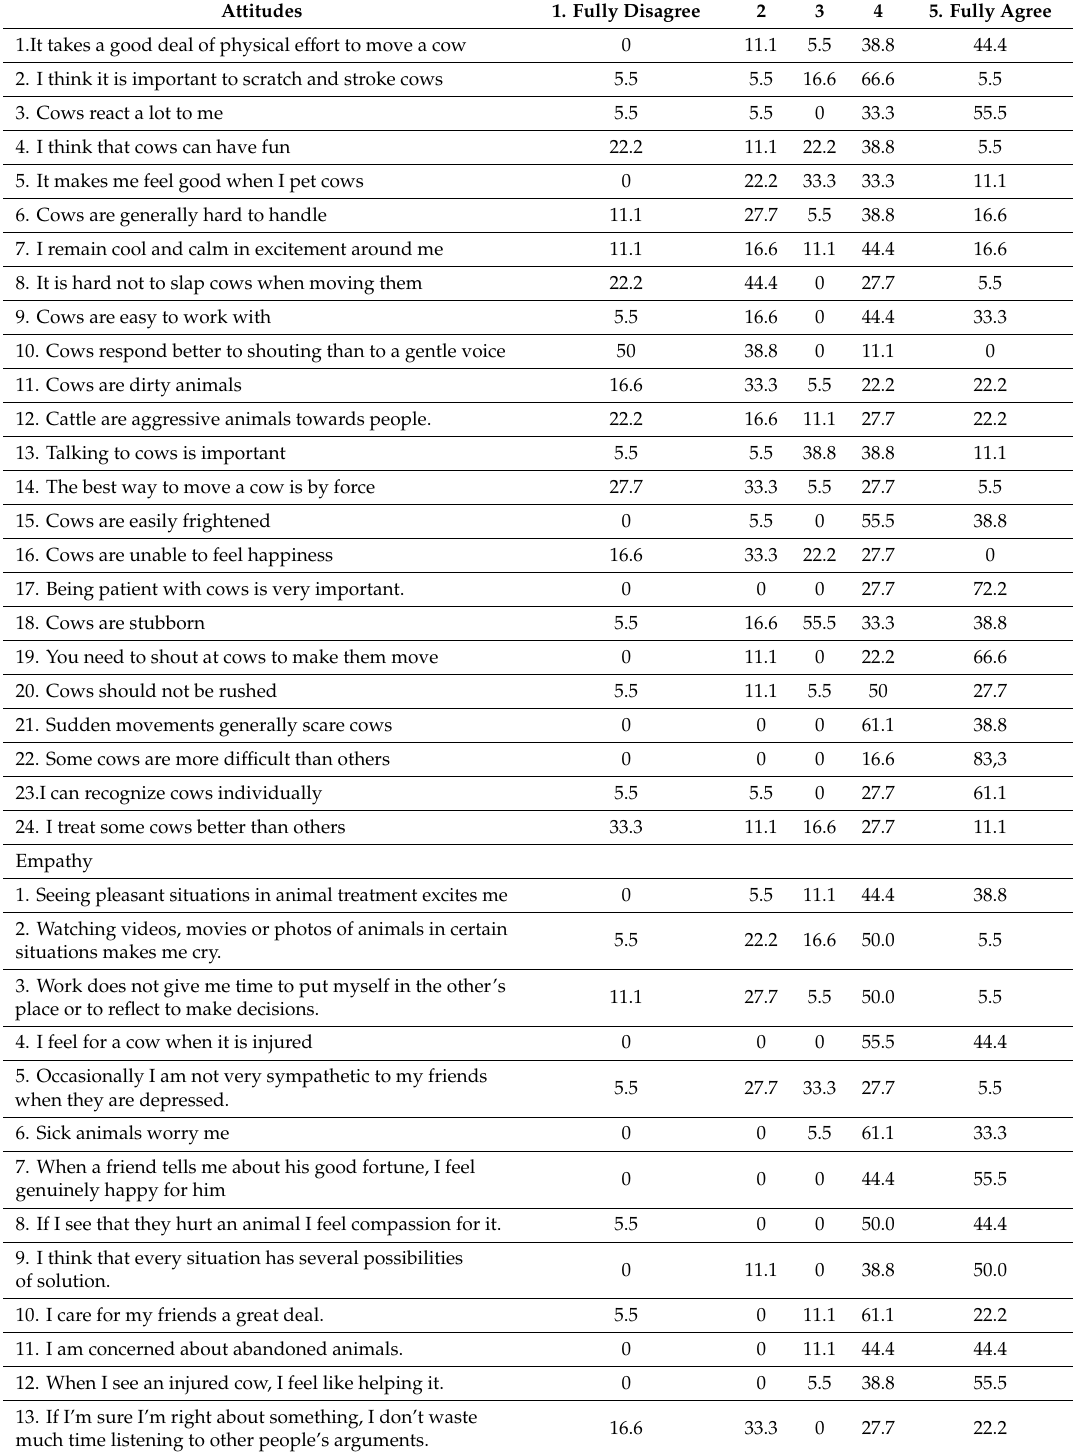
Table A1. Percentages of responses (from 1—fully disagree to 5—fully agree) characterizing handlers’ ( n = 18) attitudes and empathy toward